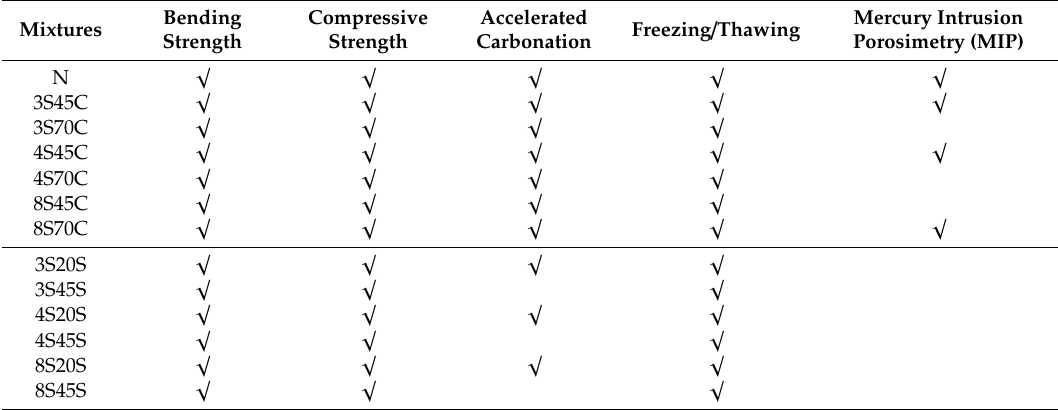
Table 3. Test items for measurement of materials properties.